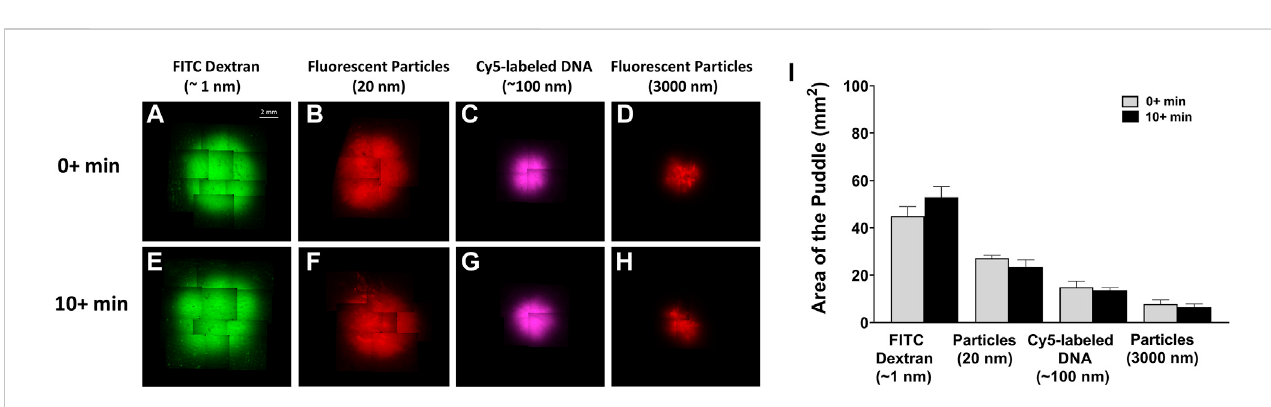
FIGURE 6 Puddle dispersiondemonstrates no time dependence. ×4 objective top-view fl uorescentimages of thepuddle momentarily 0+ min, (A – D) or 10+ min, (E – H) post 50 µL injection of the different material solutions. (I) Area quanti fi cation of the puddles, represented by mean ± SD. n = 3 each. No statistical signi fi cance is detected between areas of the different time